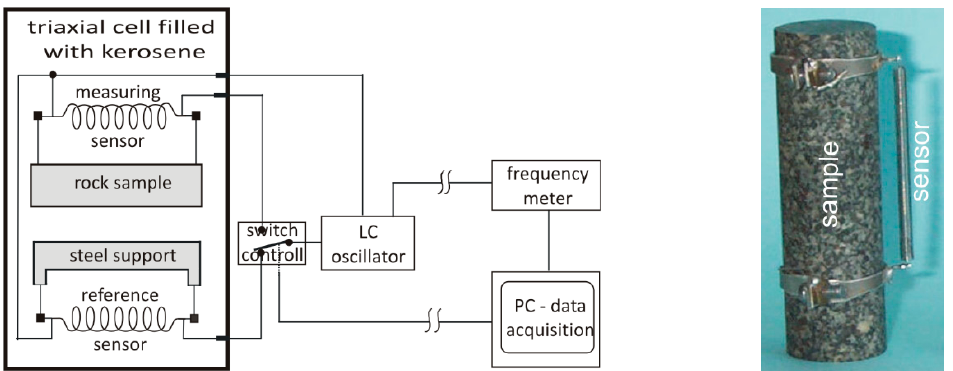
Figure 5. The idea behind the measurement of deformation using an inductive sensor in a reference system ( left ) and a photograph of a sensor installed on a sample ( right ); reproduced from [35] Int. J. Rock Mech. Min. Sci. Geomech. Abstr.: 2004. Reproduced from [35], the name of the publisher Elsevier: 2004.